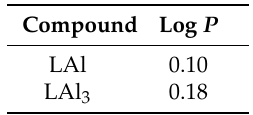
Table 2. Octanol–water partition coefficients (log P ) of Al salophen complexes.